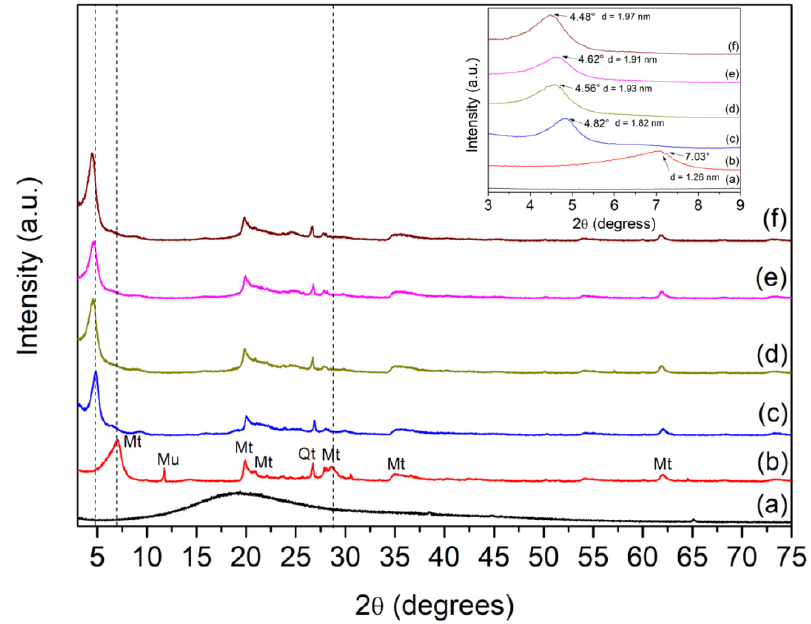
Figure 1. XRD patterns for ACN ( a ), Bent ( b ), CTAB/Bent ( c ), CTAB/ACN/Bent-4 ( d ), CTAB/ACN/Bent-7 ( e ), and CTAB/ACN/Bent-10 ( f ).